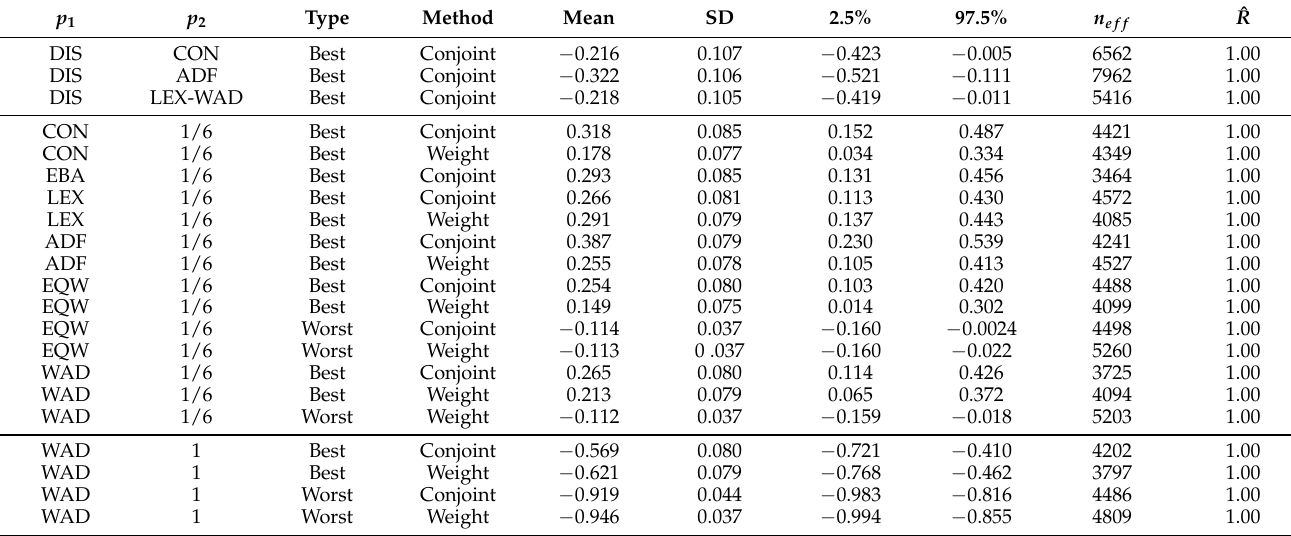
Figure 4. Worst-choice rate of the conjoint analysis and weight estimation for the single- and two- stage decision strategies. Note: ADF: additive difference; CON: conjunctive; DIS: disjunctive; EBA: elimination by aspects; EQW: equal-weighted strategy; LEX: lexicographic; LEX-S: lexicographic semi-order; MCD: majority of confirming dimensions; STR: strategy; WAD: weighted additive. Table 1. Results of the Bayesian